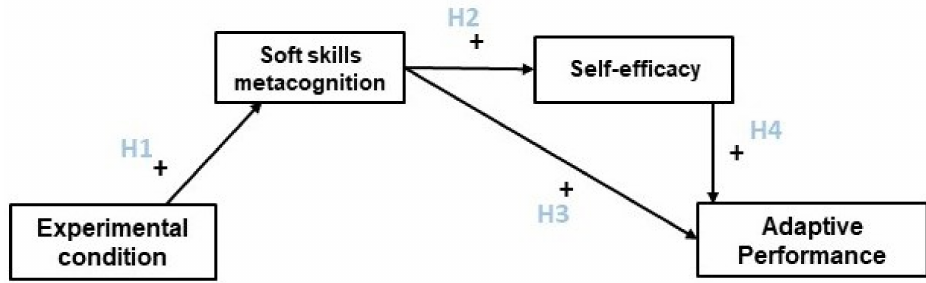
Figure 1. Model for a Soft Skills Awareness